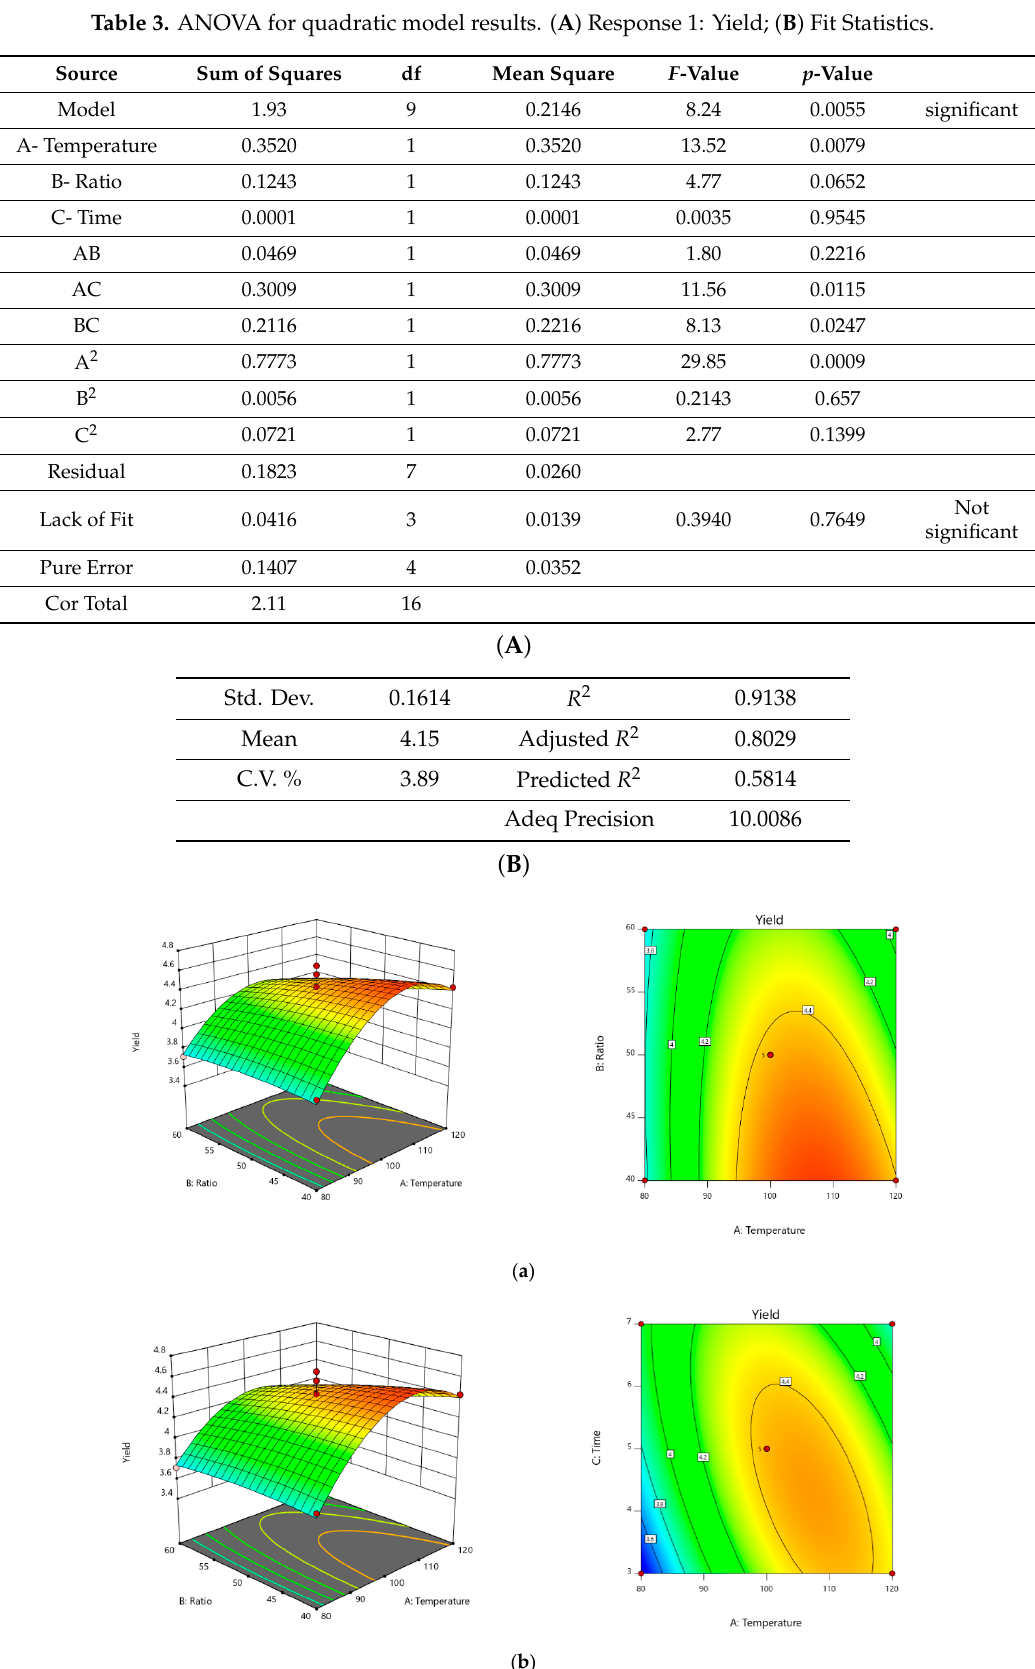
Table 3. ANOVA for quadratic model results. ( A ) Response 1: Yield; ( B ) Fit Statistics.